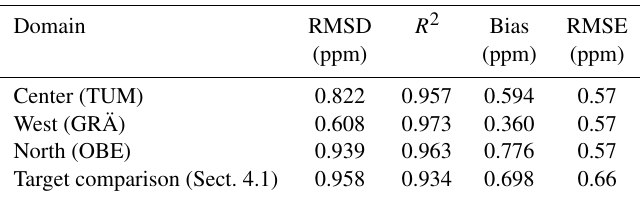
Table 2. Regression results of collocated X CO is biased high against